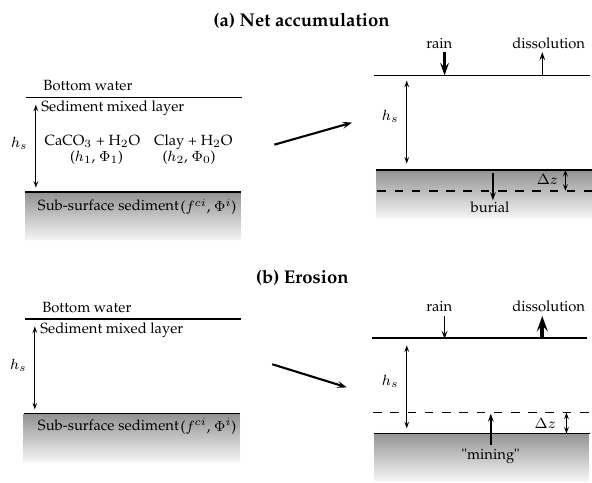
Fig. 4. Schematic representation of the sediment model. The sediment mixed layer (thickness h s ) can be sepa- rated into pure calcite plus pore water (thickness h 1 , porosity φ 1 ) and pure clay plus pore water (thickness h 2 , porosity φ 0 ). (a) Net accumulation equals CaCO 3 rain minus dissolution. At the bottom of the sediment mixed layer, an amount equal to net accumulation is removed via burial ( 1z ). (b) If dissolution of CaCO 3 exceeds the rain of CaCO 3 plus clay, chemical erosion occurs. Previously deposited, underlying sediment is reintroduced into the top layer and exposed to disso- lution (“mining”). Sub-surface sediment properties are based on the initial steady-state configuration ( f c i and φ i is the initial calcite fraction and porosity,